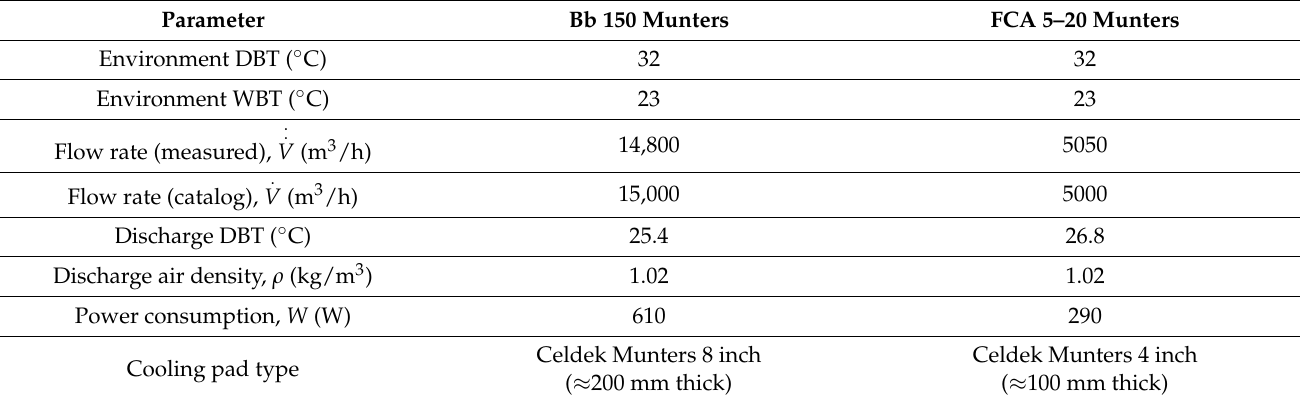
Table 3. Laboratory test